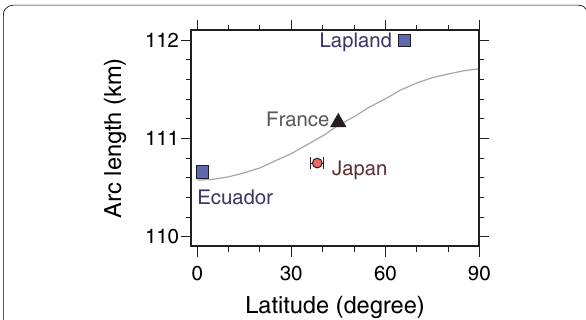
Fig. 2 Meridian arc length measurements in Japan and the world. Comparison of the meridian arc length measurements in eighteenth century by Europeans (expedition to Ecuador and Lapland, northern Finland, in early eighteenth century and measurements by the French government to establish the metric system in late eighteenth century), and around 1802 by Ino and his team in NE